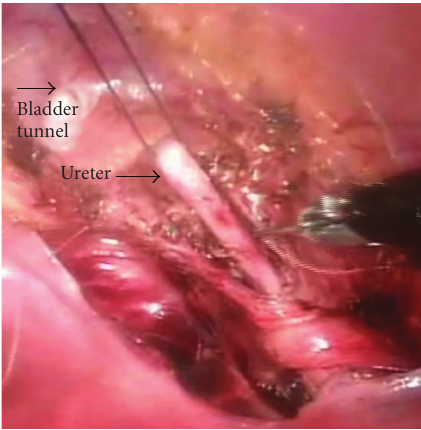
Figure 4: Demonstration of hitch stitch around right ureter for retraction (2-0